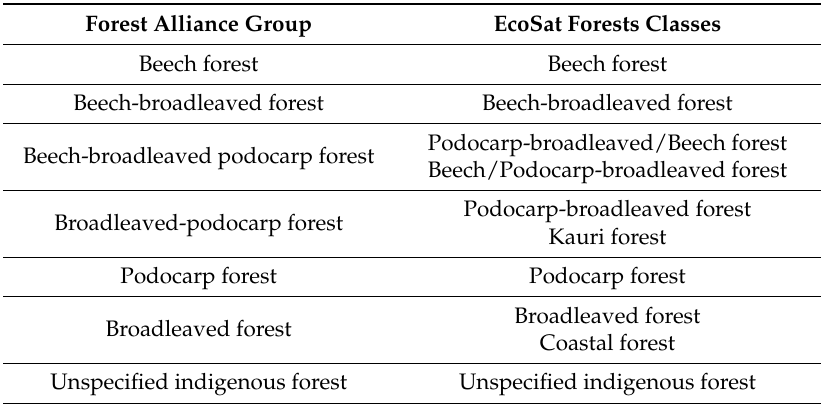
Table 1. Table for recoding EcoSat forest class to forest alliance group.